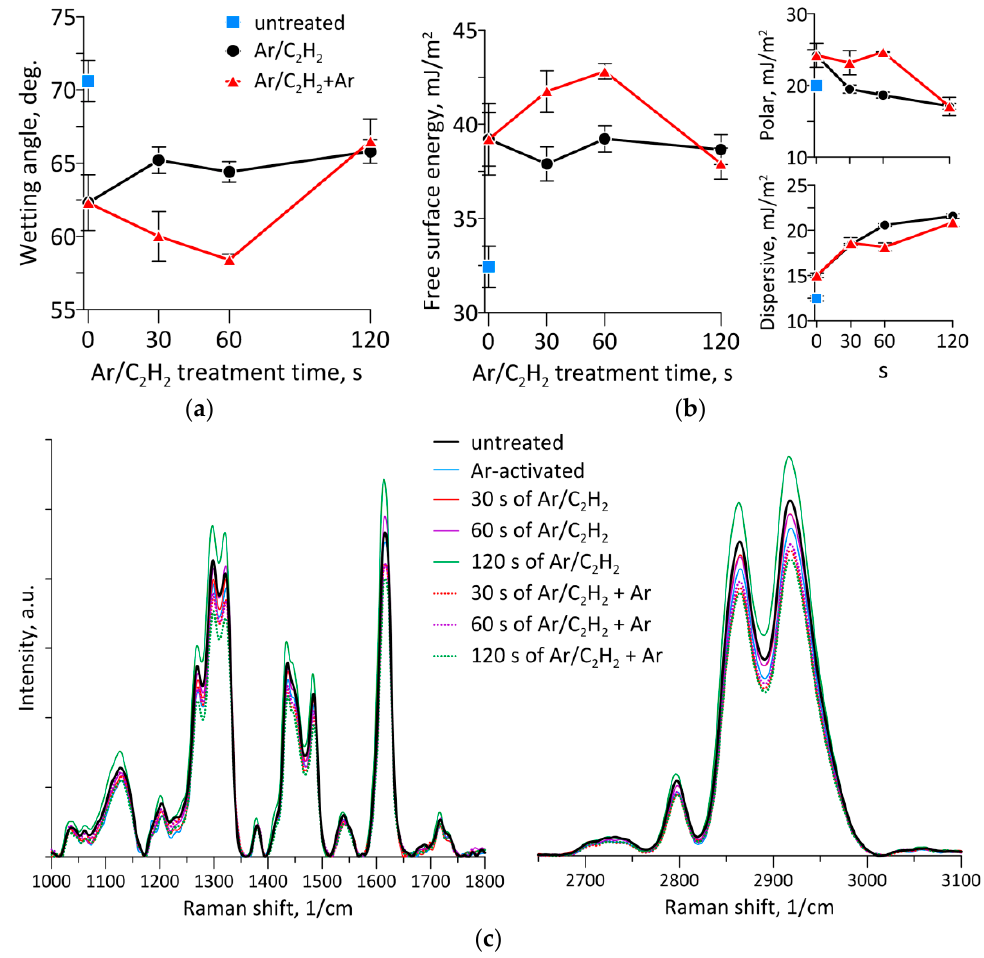
Figure 4. Wetting contact angle ( a ), free surface energy ( b ) and Raman spectroscopy ( c ). The sorption of proteins onto the surface nonlinearly depends on the combination of wettability [32], free surface energy (in particular, albumin is sensitive to the polar energy component [33]), and roughness [34] (the roughness affects the available area, but may also change the conformation of protein molecules). In our case, albumin sorption was positively affected by the argon post-treatment of Ar/C 2 H 2 coatings (Figure 5). The reasons for this are the wettability as well as the polar component of the free surface energy. Local physical and chemical heterogeneities of pristine polyurethane, as well as after Ar/C 2 H 2, hamper the uniform adhesion of albumin on the surface—the nanostructures of protein films have heterogeneities, but argon post-treatment makes the protein layer smooth and uniform (see images in Figure 5). Micro- and nanocracks are visible on uniaxially deformed (50% of elongation) surfaces after certain cases of treatment (Figure 6). The study of untreated stretched polyurethane, as well as after argon activation, did not reveal any surface defects (these images are not